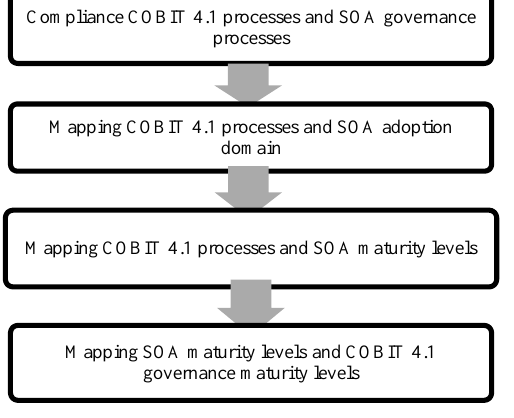
Figure 2. Main steps of proposed